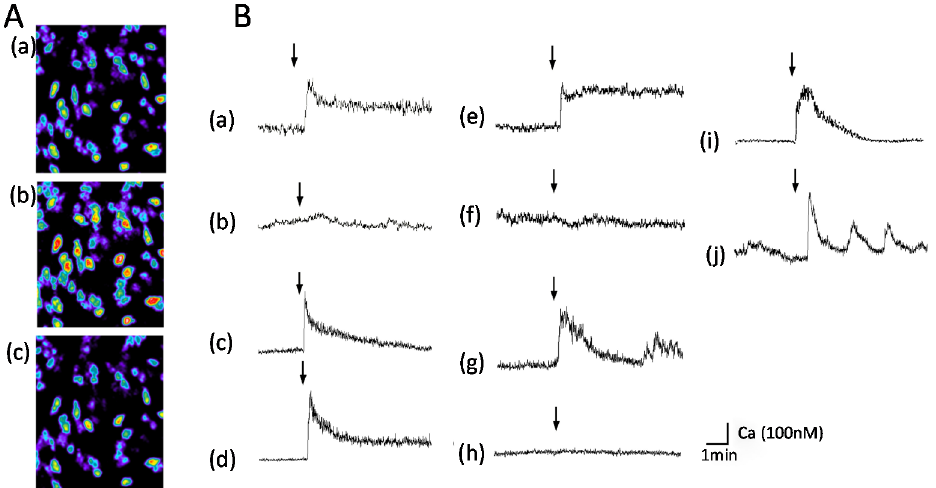
Figure 2. Temporal changes [Ca 2+ ] i in GT1-7 cells after exposure to amyloidogenic proteins. ( A